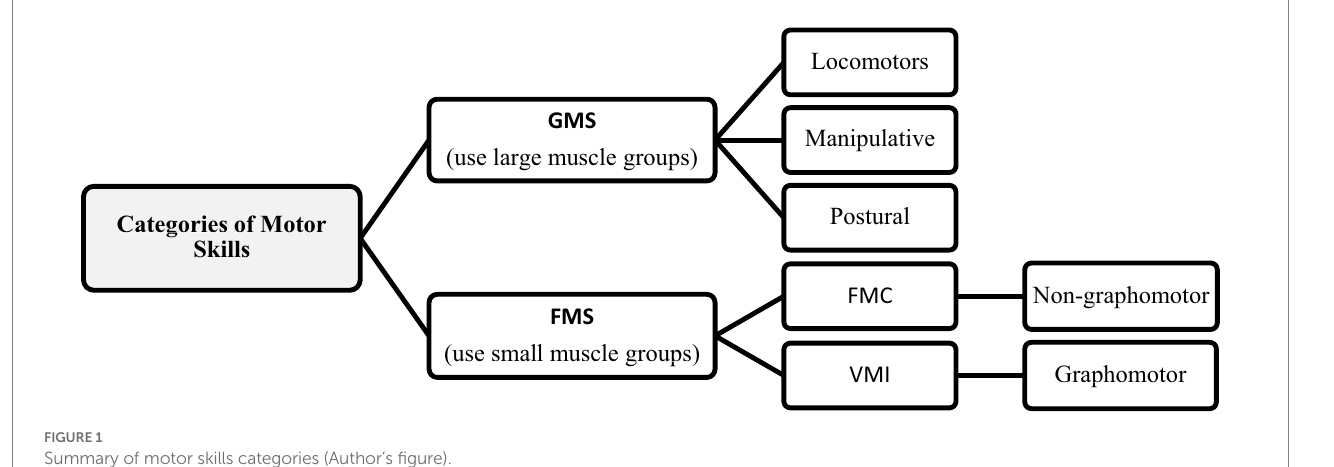
FIGURE 1 Summary of motor skills categories (Author’s